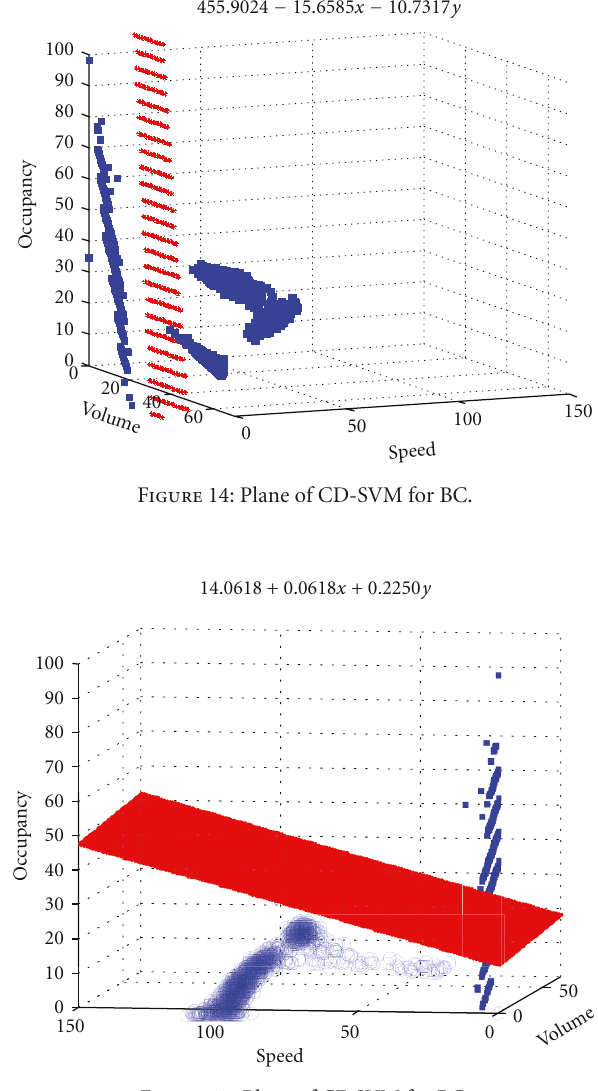
Figure 15: Plane of CF-SVM for BC.